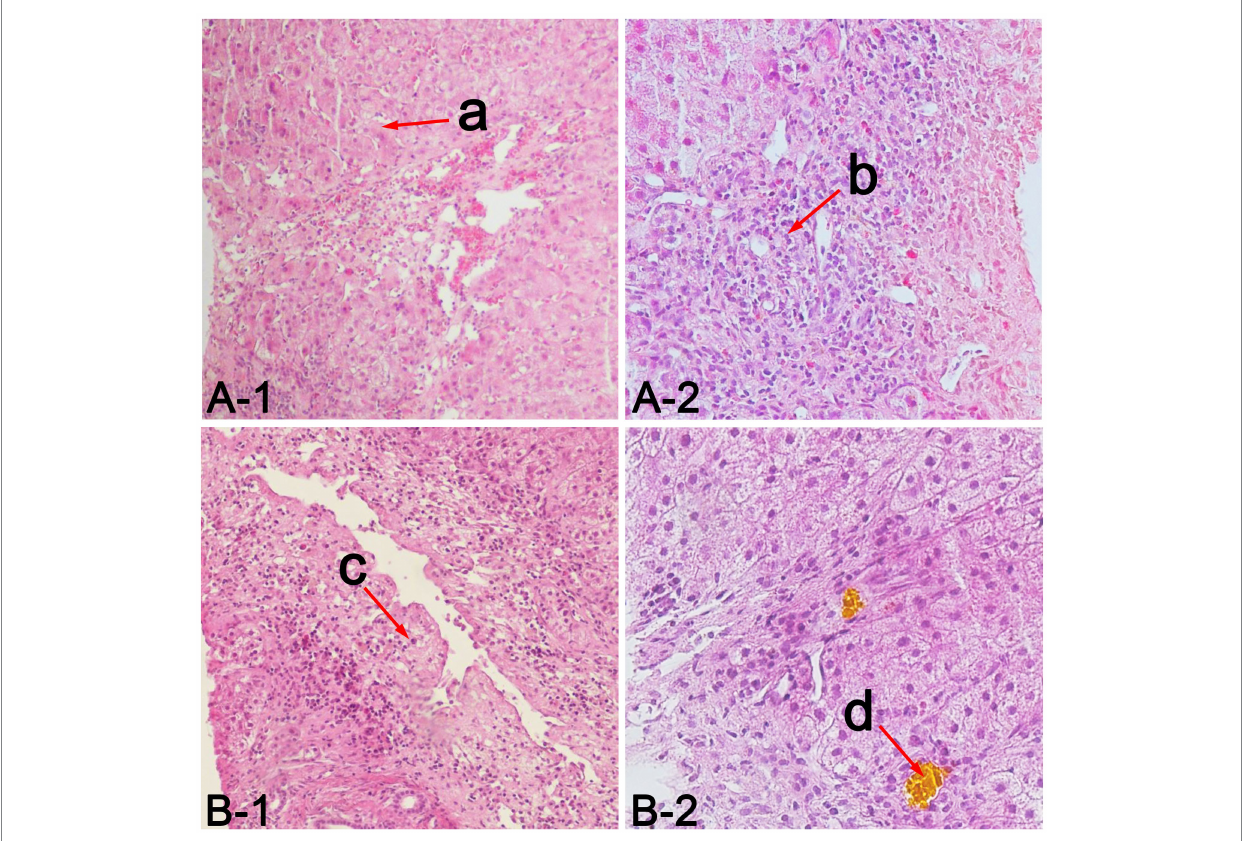
FIGURE 2 Liver pathological findings of patients. (A) represents case 1, (B) represents case 2, a in A-1 indicates diffuse hydropic degeneration, spotty necrosis and fusion necrosis of hepatocytes (hematoxylin and eosin, 100×), b in A-2 indicates numerous neutrophils, lymphocytes and eosinophils infiltration in the portal area (hematoxylin and eosin, 200×), c in B-1 indicates mesh stent collapse of hepatic lobule and submassive necrosis of hepatocytes (hematoxylin and eosin, 100×), d in B-2 indicates cholestasis in bile (hematoxylin and eosin,